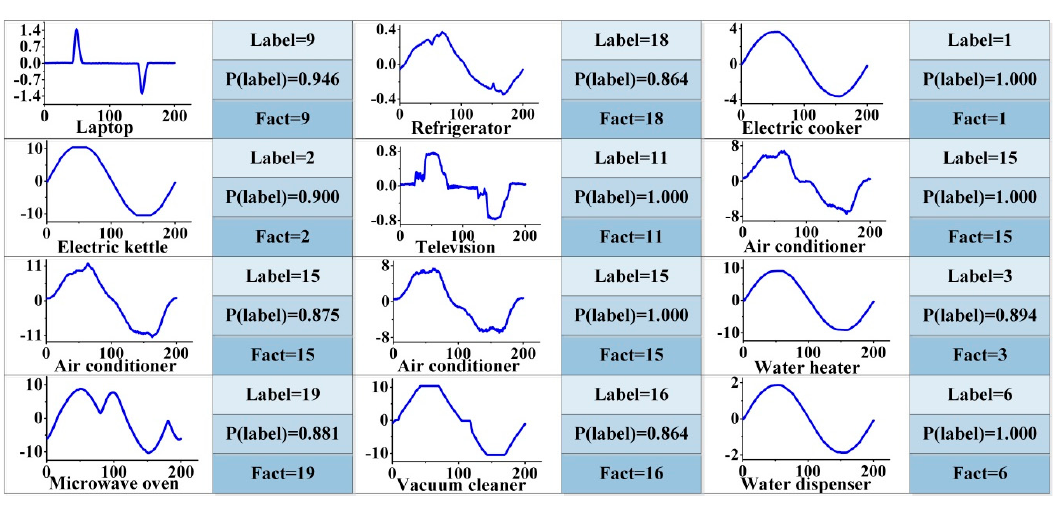
Figure 7. Labeling probability of load.